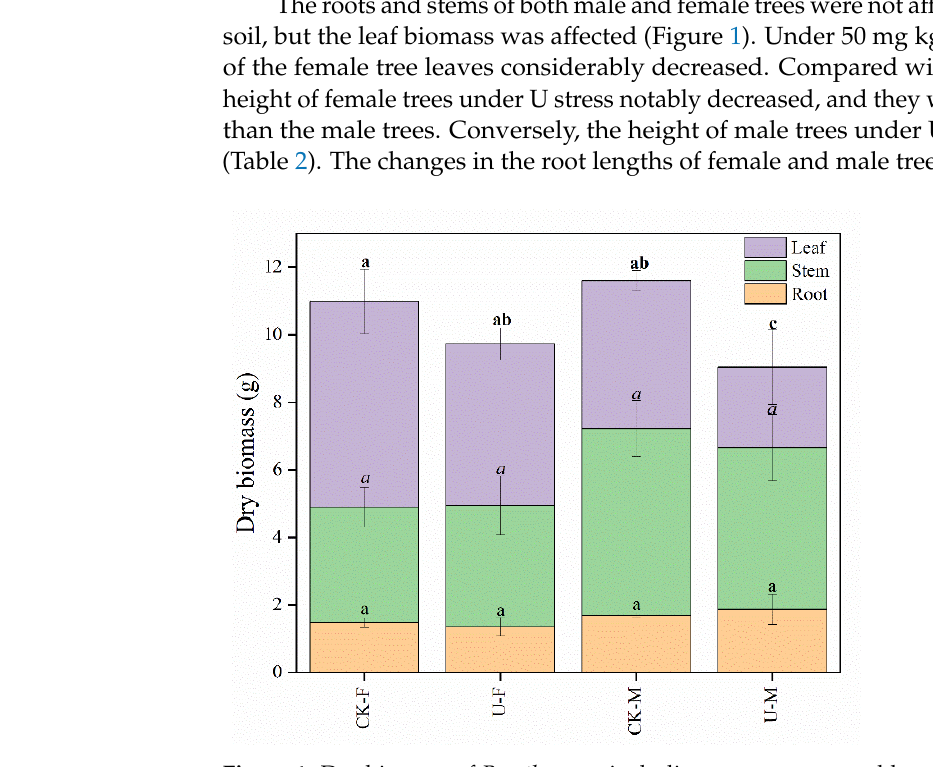
Figure 1. Dry biomass of P. cathayana , including roots, stems, and leaves. Values are expressed as means ± SE ( n = 3). Different letters represent significant differences between treatments ( p < 0.05). Table 2. Growth parameters of P. cathayana under U stress .